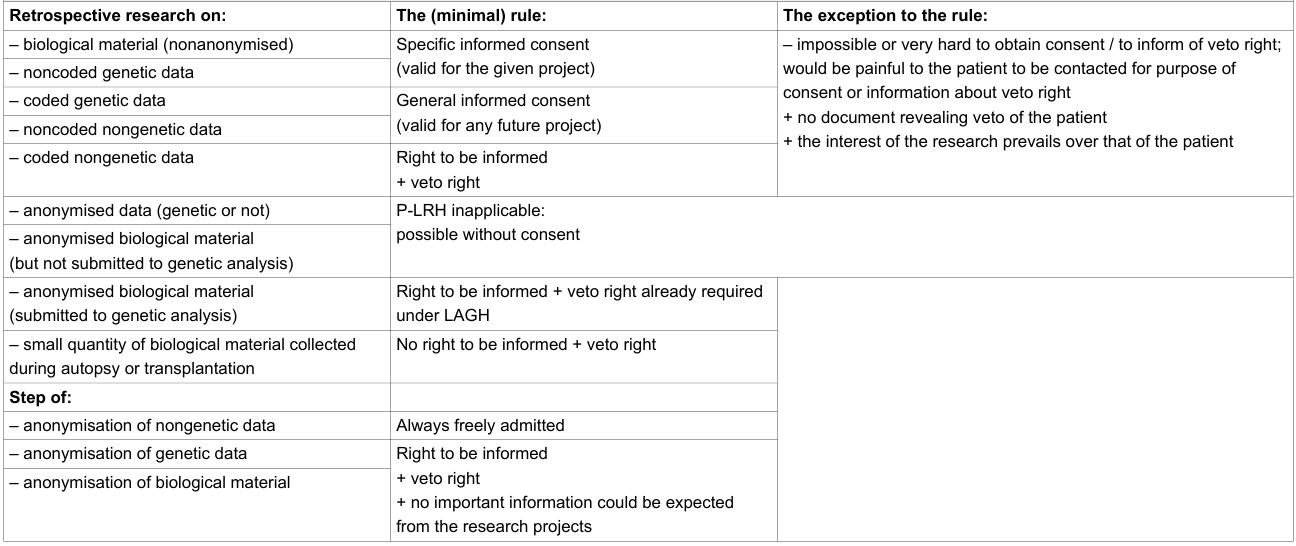
Table 2 Summary of the future rules of the P-LRH on retrospective